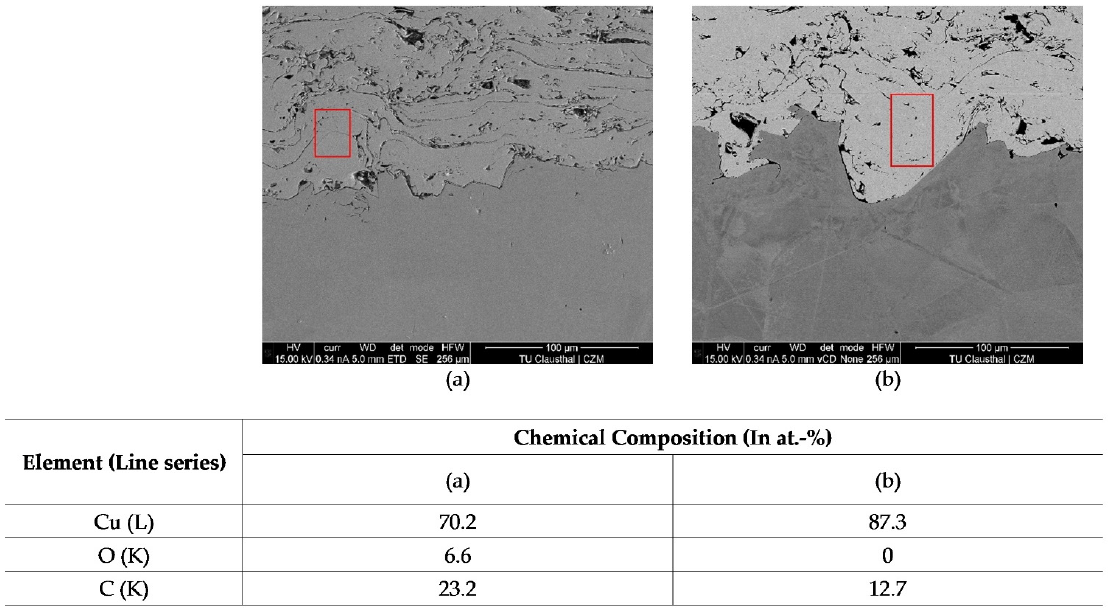
Figure 3. SEM images of cross-sections of copper coatings with their corresponding chemical composition: ( a ) blasted and sprayed in air; and ( b ) blasted and sprayed in silane-doped nitrogen.